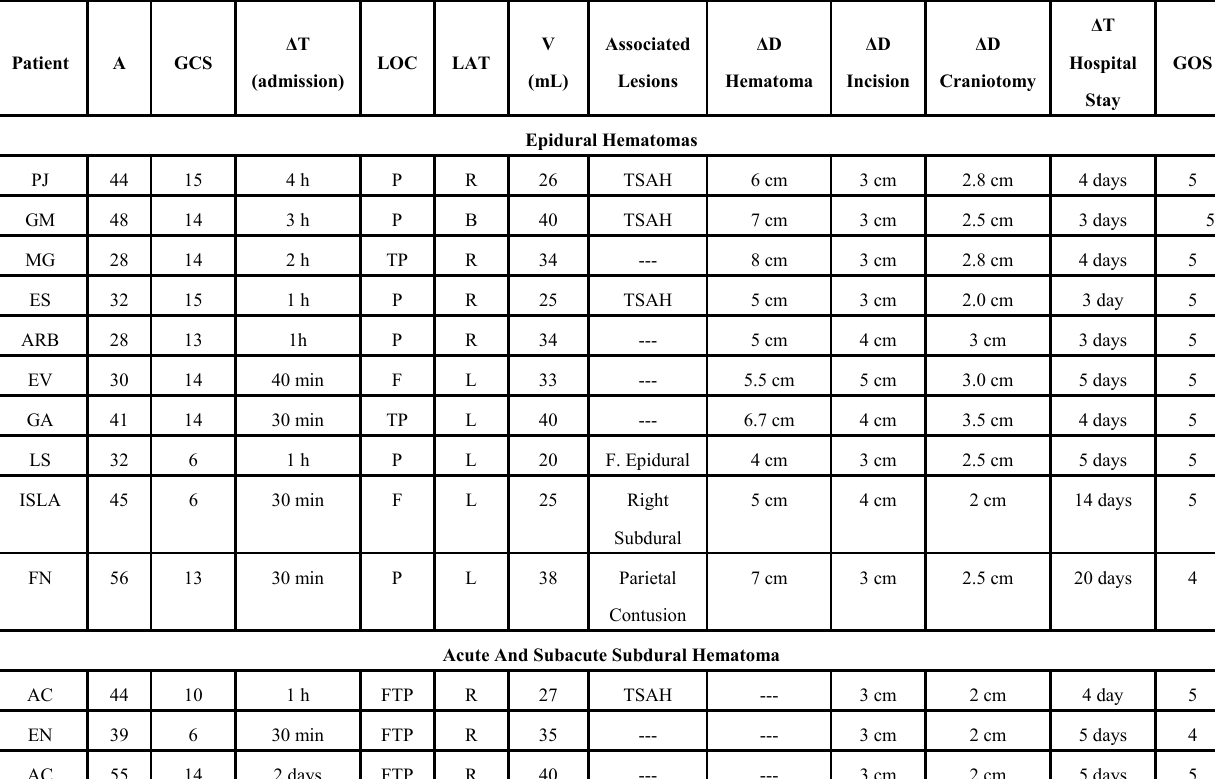
Table 1. Results. Legends: A = Age; Δ T (admission) = time until the patient was admitted to the hospital; LOC = location of the traumatic lesion (F = frontal; P = parietal; T = temporal; FTP LAT = lateralization of the traumatic lesion (R = right; L = left; B bilateral); V = traumatic lesion volume; Δ D hematoma = diameter of the hematoma (only for epidural hematomas); Δ D incision = incision length; Δ D craniotomy = diameter of the craniotomy; Δ T neuro = time of hospital stay due to neurological status; Δ T hospital = hole hospital stay time; GOS = Glasgow outcome scale after 1 month of the accident; TSAH = Traumatic Subdural Acute Hemorrhage; C Fracture = Cranial